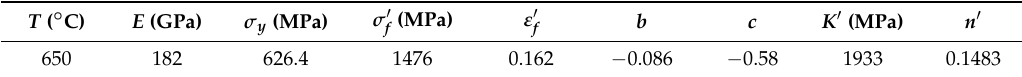
Table 1. Material properties of GH4169.